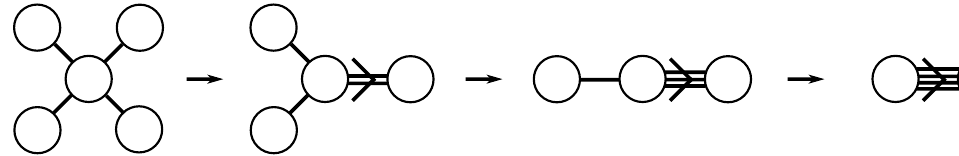
Figure 6. The change of the Dynkin diagram in the process of the successive Higgsings of SU(2) .